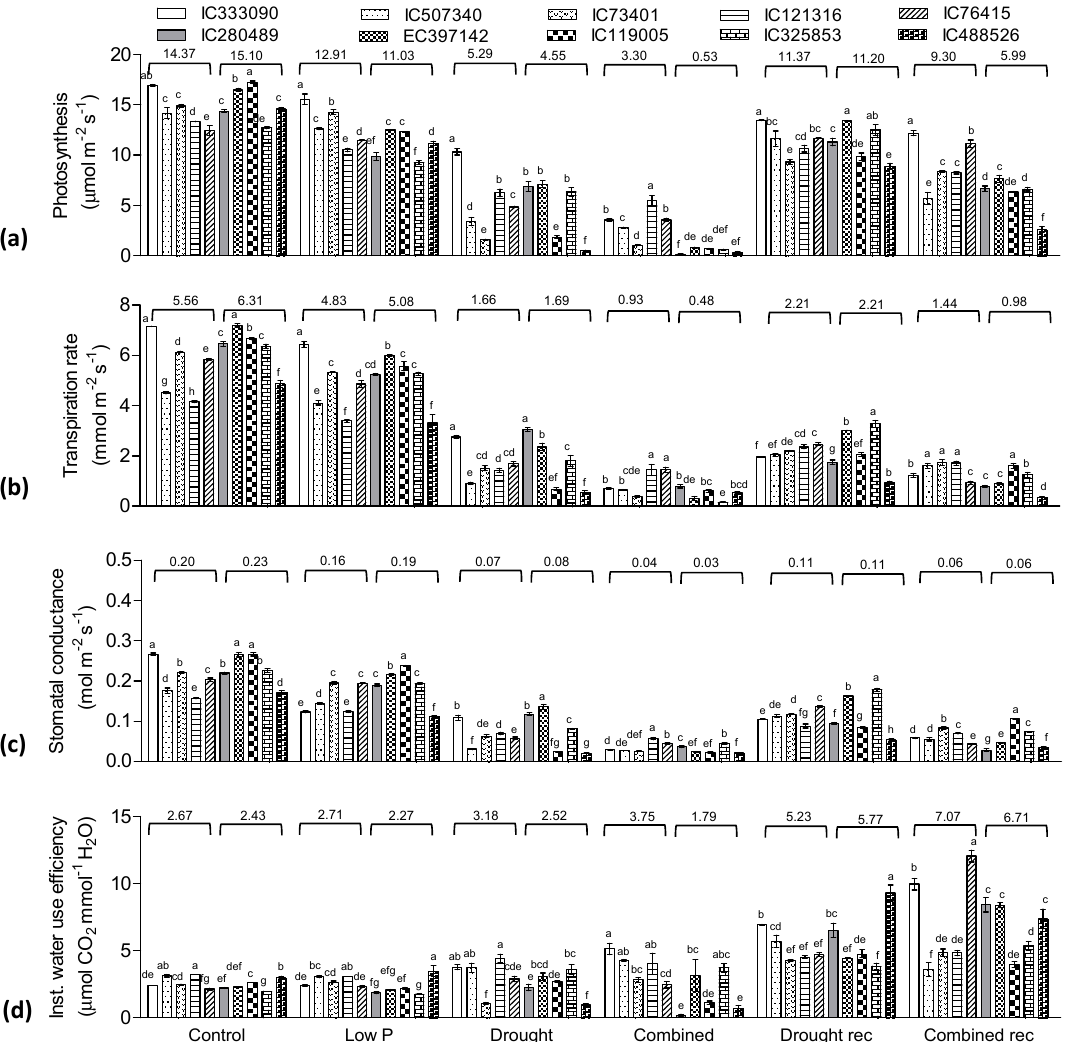
Figure 5. Effect of low P, drought, and combined stress on ( a ) rate of photosynthesis, ( b ) transpiration, ( c ) stomatal conductance, and ( d ) instantaneous water use efficiency in 10 mung bean accessions. Values on bars 1–5 and 6–10 represents mean of tolerant and sensitive accessions, respectively. The letters on each bar denotes significant difference between accessions in each treatment. Error bars indicate mean ± SEm.